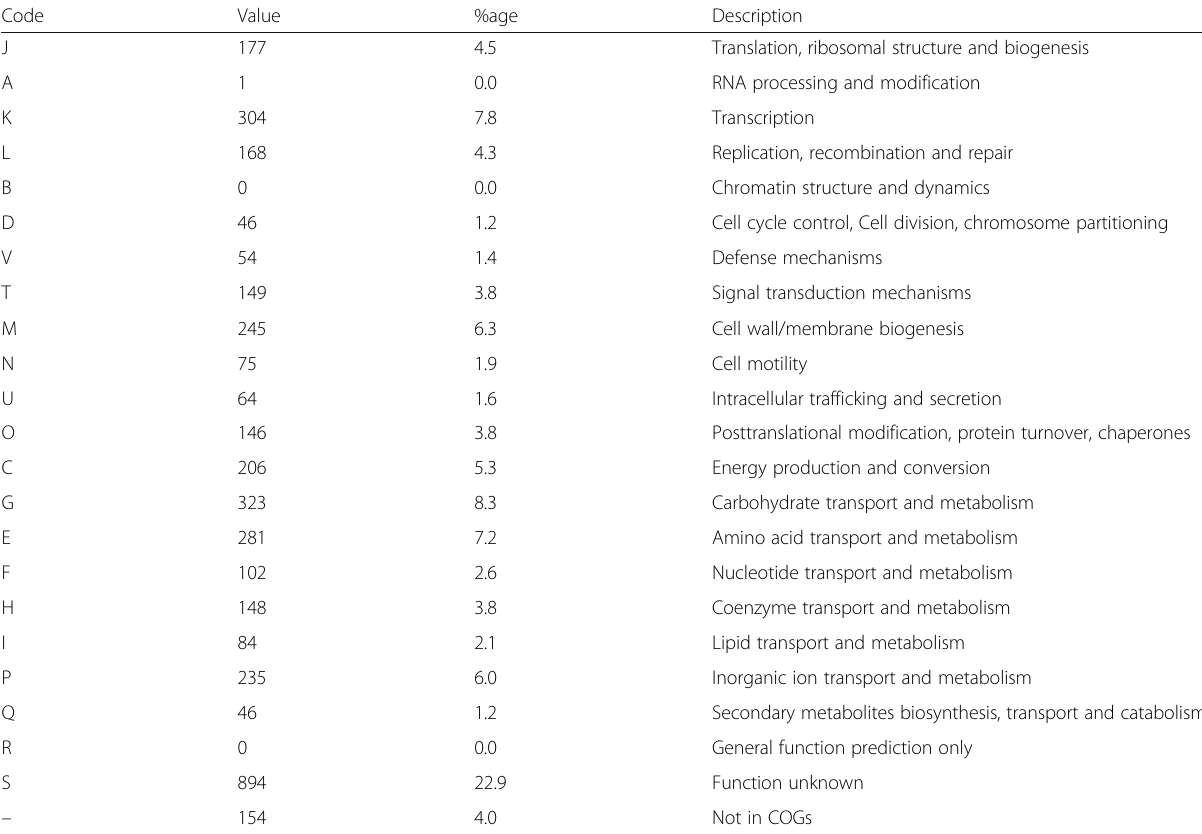
Table 5 Summary of the average number of genes and percentage of each genome representing each COG functional category associated with the 26 C. sakazakii strains evaluated in this study a